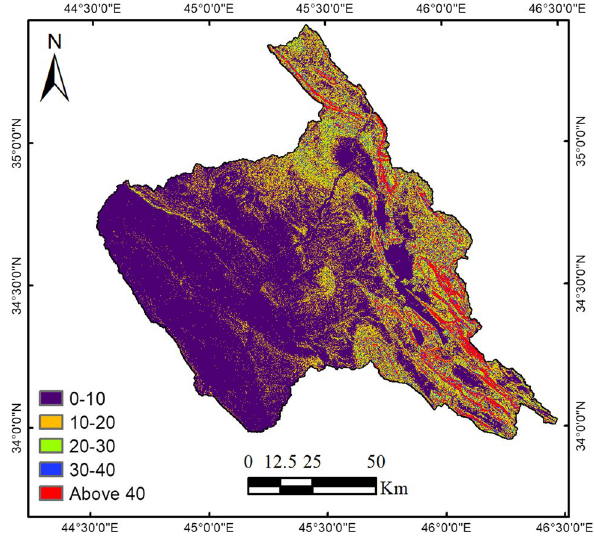
Fig. 8 Land slope of Hemren dam reservoir